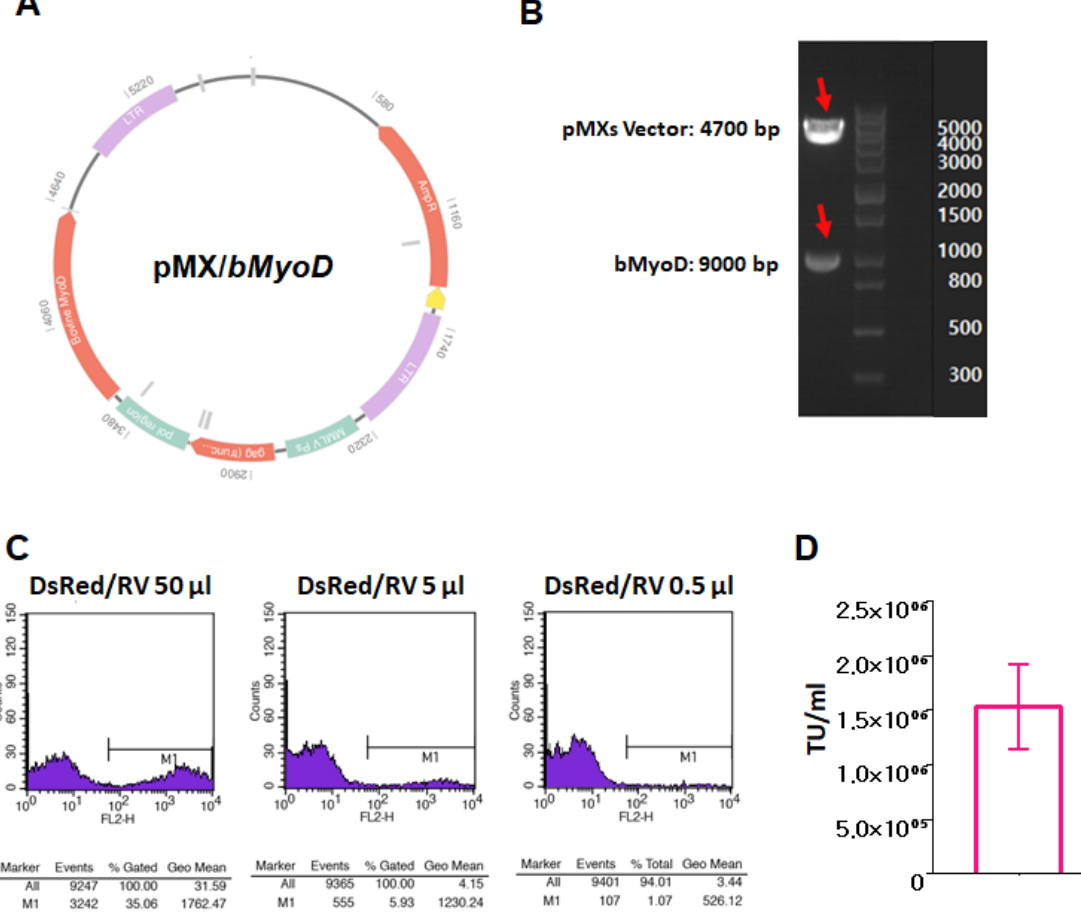
Figure 3. Viral-based direct reprogramming using bMyoD retrovirus. ( A ) Plasmid constructs of pMX/ bMyoD . ( B ) PCR gel of double-digested pMX/ bMyoD retroviral vector. Red arrows indicate pMX and bMyoD, respectively. ( C ) Histogram of FACS for infected HT1080 with concentrated retrovirus. ( D ) Titer of concentrated retrovirus. n = 3 per group.